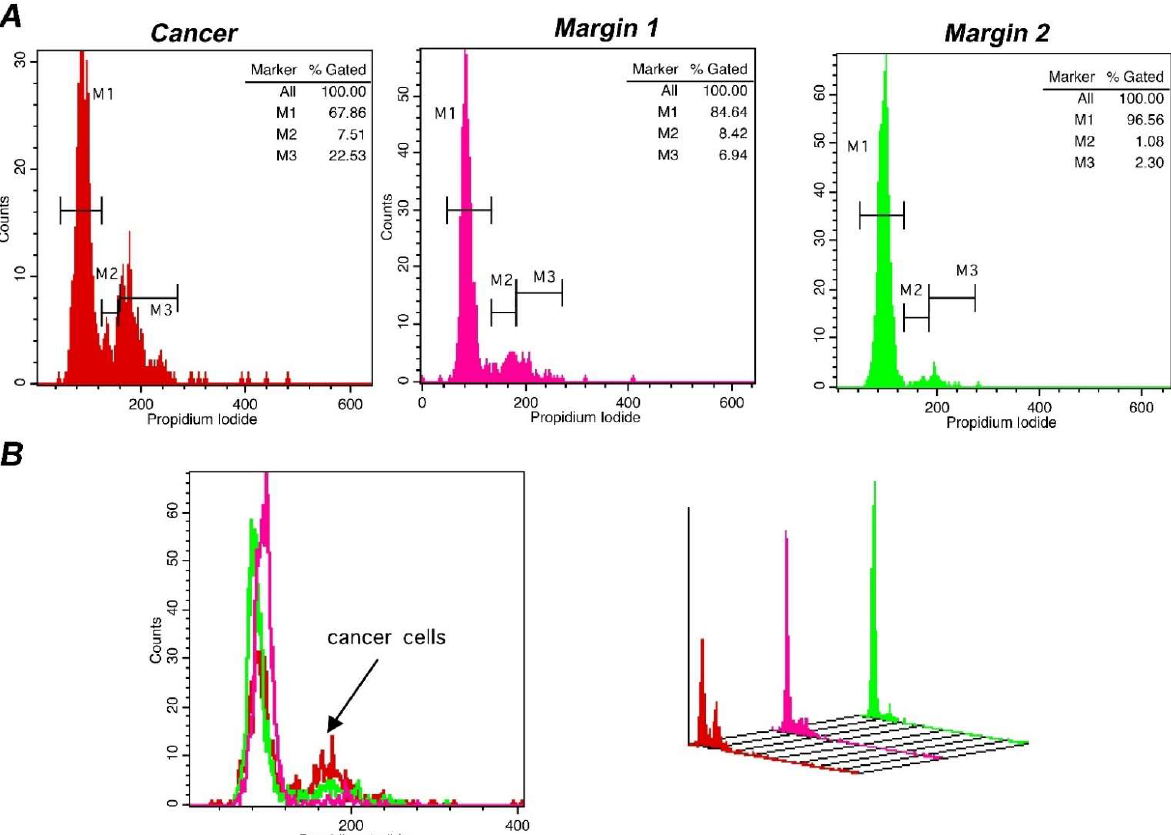
Figure 6. Margin assessment of a representative case of bladder cancer with iFC. DNA analysis of cancer cells, as described leads to quantification of cell cycle phases G0/G1. S and G2/M by the respective markers M1, M2 and M3. ( A ) DNA analysis of a tumor sample (red), a positive (pink) and a negative margin (green). Proliferating cancer cells (cumulative percentage in M2 and M3, or tumor-index) allows the assessment of margin status, where a percentage beyond the cut-off value of 6.5% is indicative of the presence of cancer cells in a given margin. In the presented case, margin 1 is positive, with a Tumor-index of ~15%, while margin 2 is negative, with a Tumor-index of ~3.4%, below the cut-off value. ( B ) overlays in 2 dimensions ( left ) and 3 dimensions ( right ). The presence of proliferating cancer cells is defined by the black arrow in the 2-D plot.